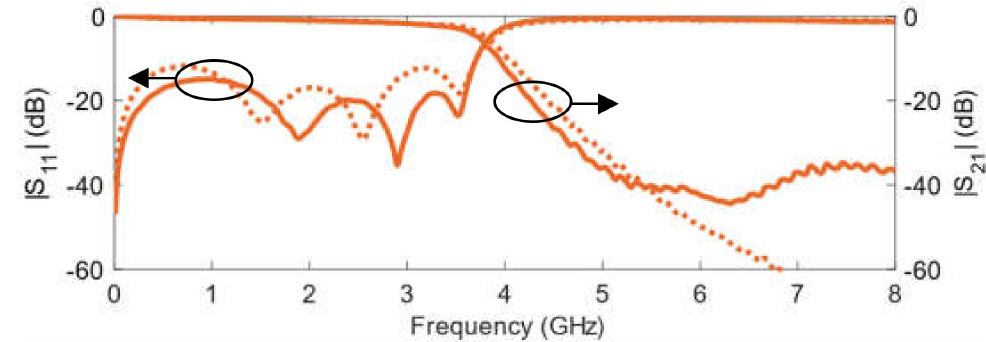
Figure 20. Measured scattering parameters for the stepped substrate low pass filter ( solid line ) and the conventional design on a constant 0.7 mm high substrate ( dotted line ).